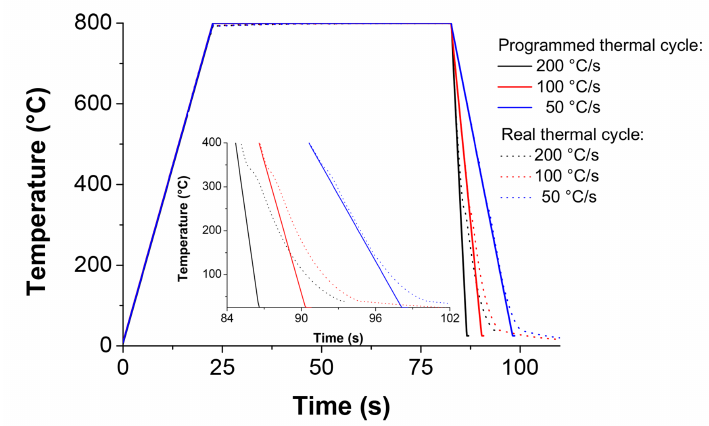
Figure 6. Experimental temperature–time profiles obtained from the dilatometric output data vs. programmed thermal cycles.